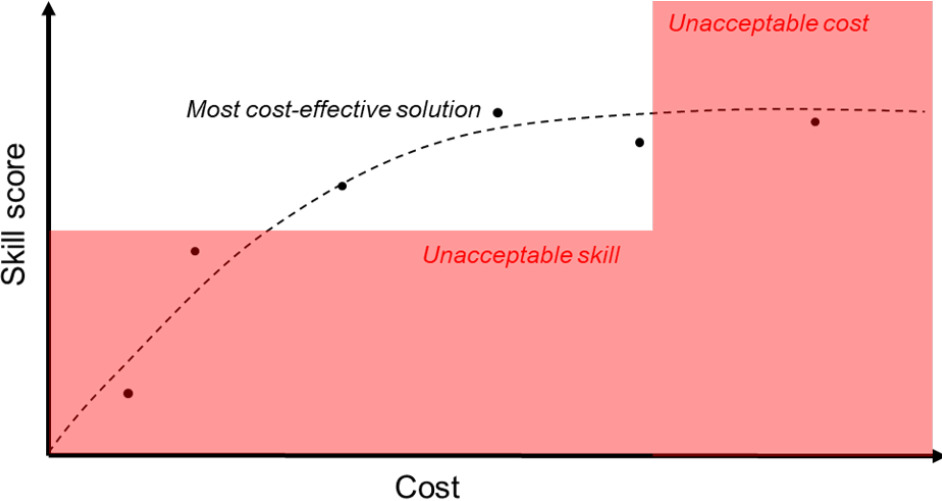
Figure 1. Schematic representation of the expected skill score against cost score for an example wind energy